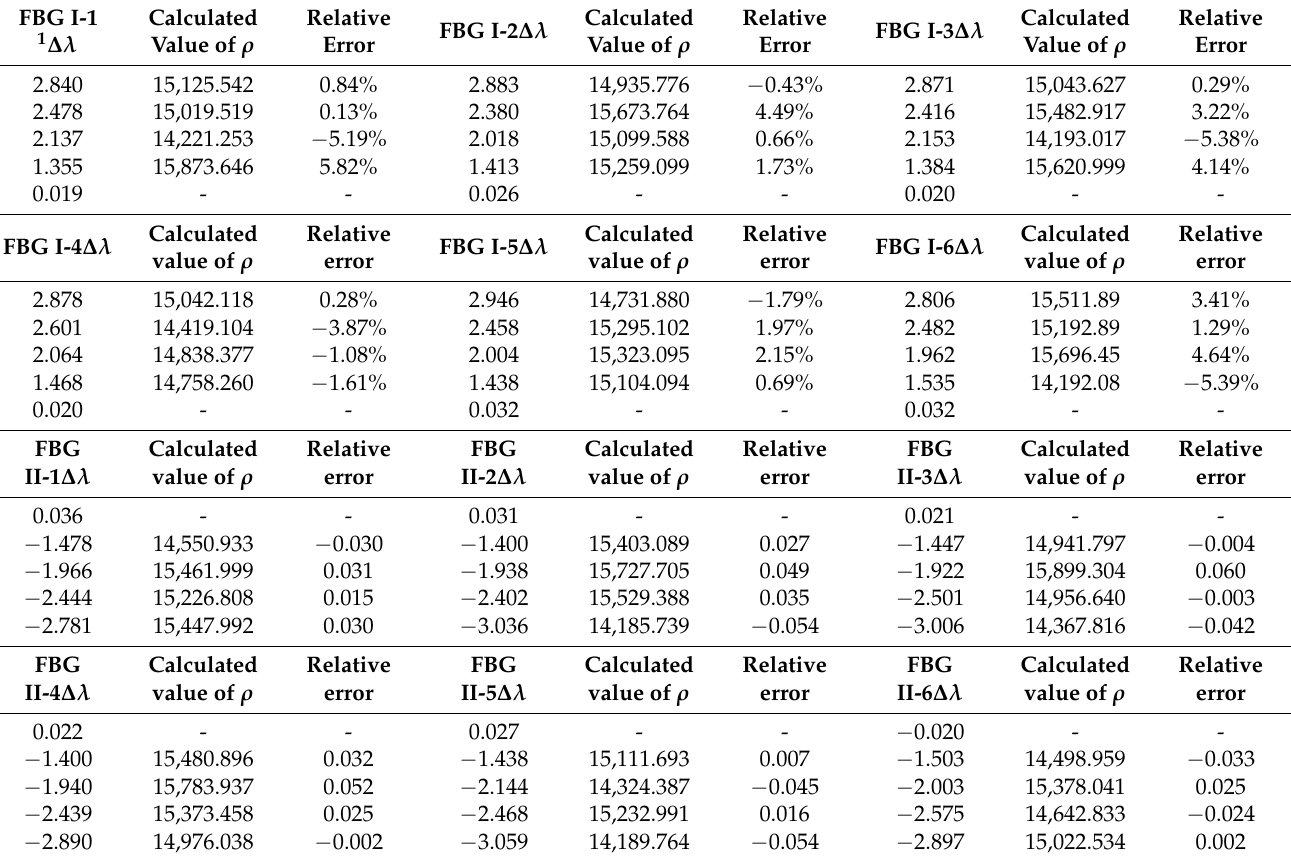
Table 4. Variation of FBG central wavelength measured by experiment and calculated